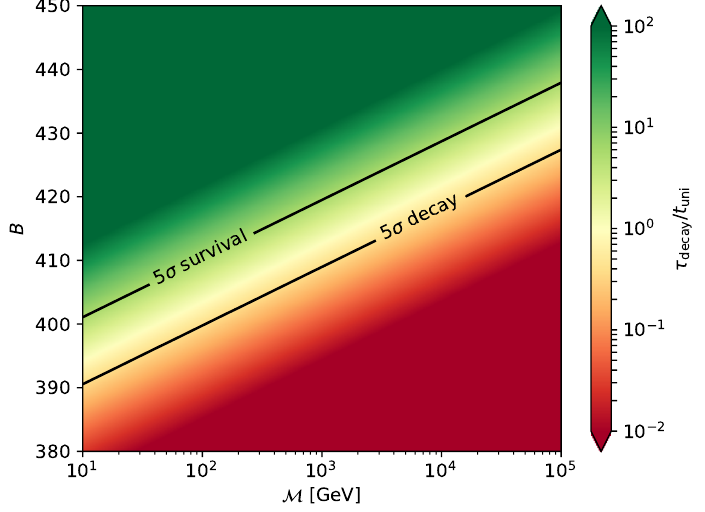
Figure 2 . The lifetime of the metastable vacuum (cid:28) decay relative to the age of the universe t uni is given in the plane of the scale M and the bounce action B . The contour lines denote a 5 (cid:27) probability for decay and survival,